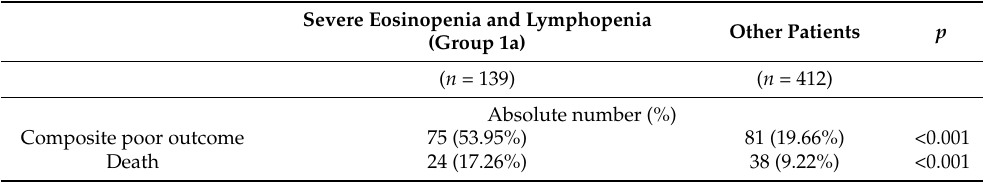
Table 4. Mortality and composite poor outcome including ICU admission and/or oxygen at >6 L/min and/or death in hospitalized COVID-19 patients with and without severe eosinopenia + lymphopenia. Severe Eosinopenia and Lymphopenia Other Patients (Group 1a)